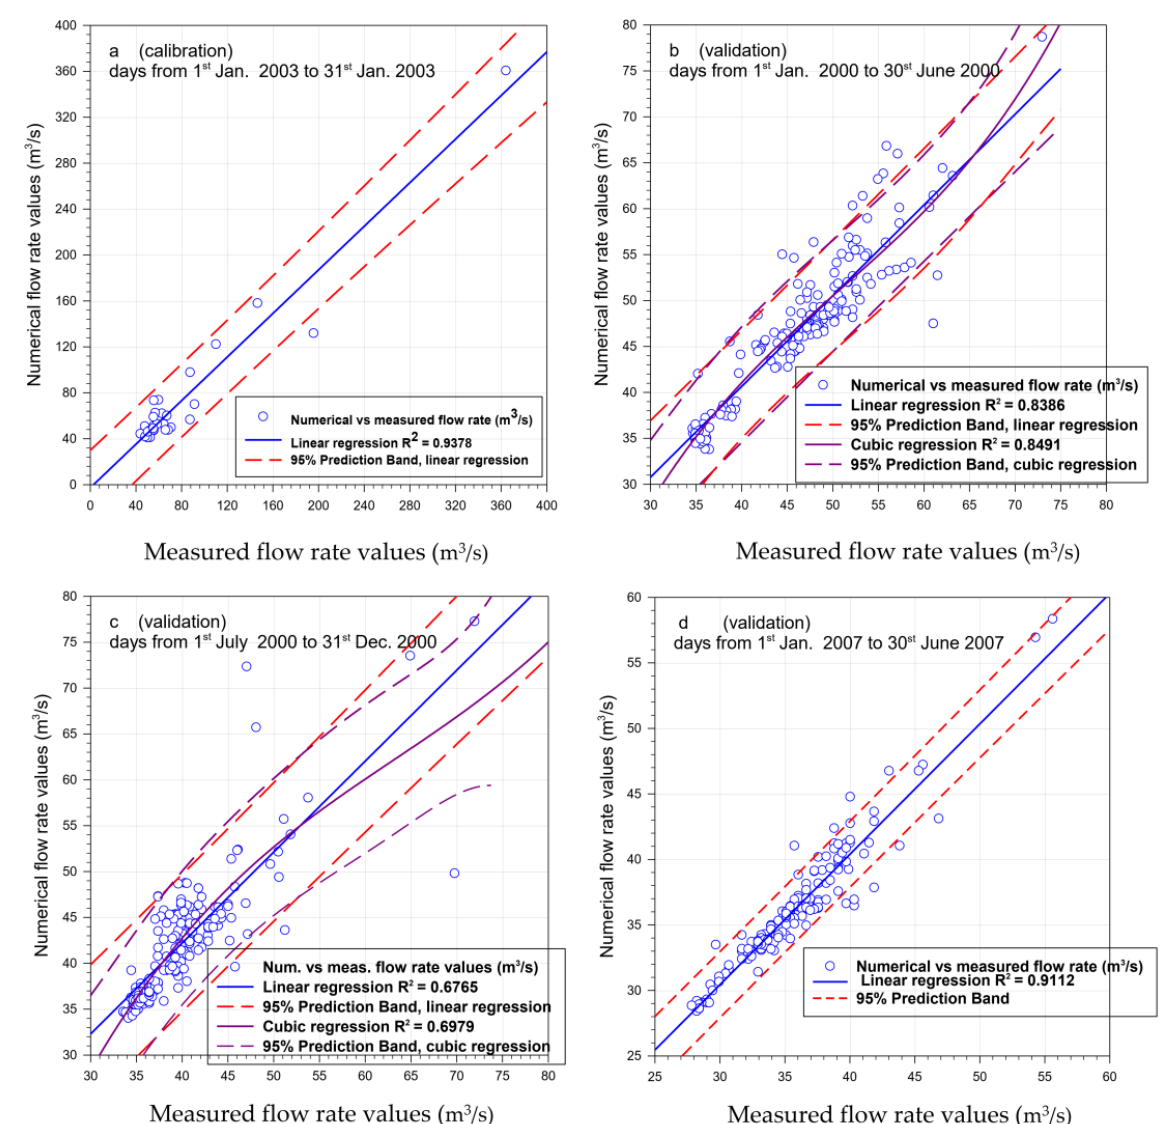
Figure 8. Regression between numerically predicted and measured flow rate at S. Teresa Station, during the selected time periods; days: ( a ) from 1 January 2003 to 31 January 2003 (calibration); ( b ) from 1 January 2000 to 30 June 2000 (validation); ( c ) from 1 July 2000 to 31 December 2000 (validation); ( d ) from 1 January 2007 to 30 June 2007 (validation).